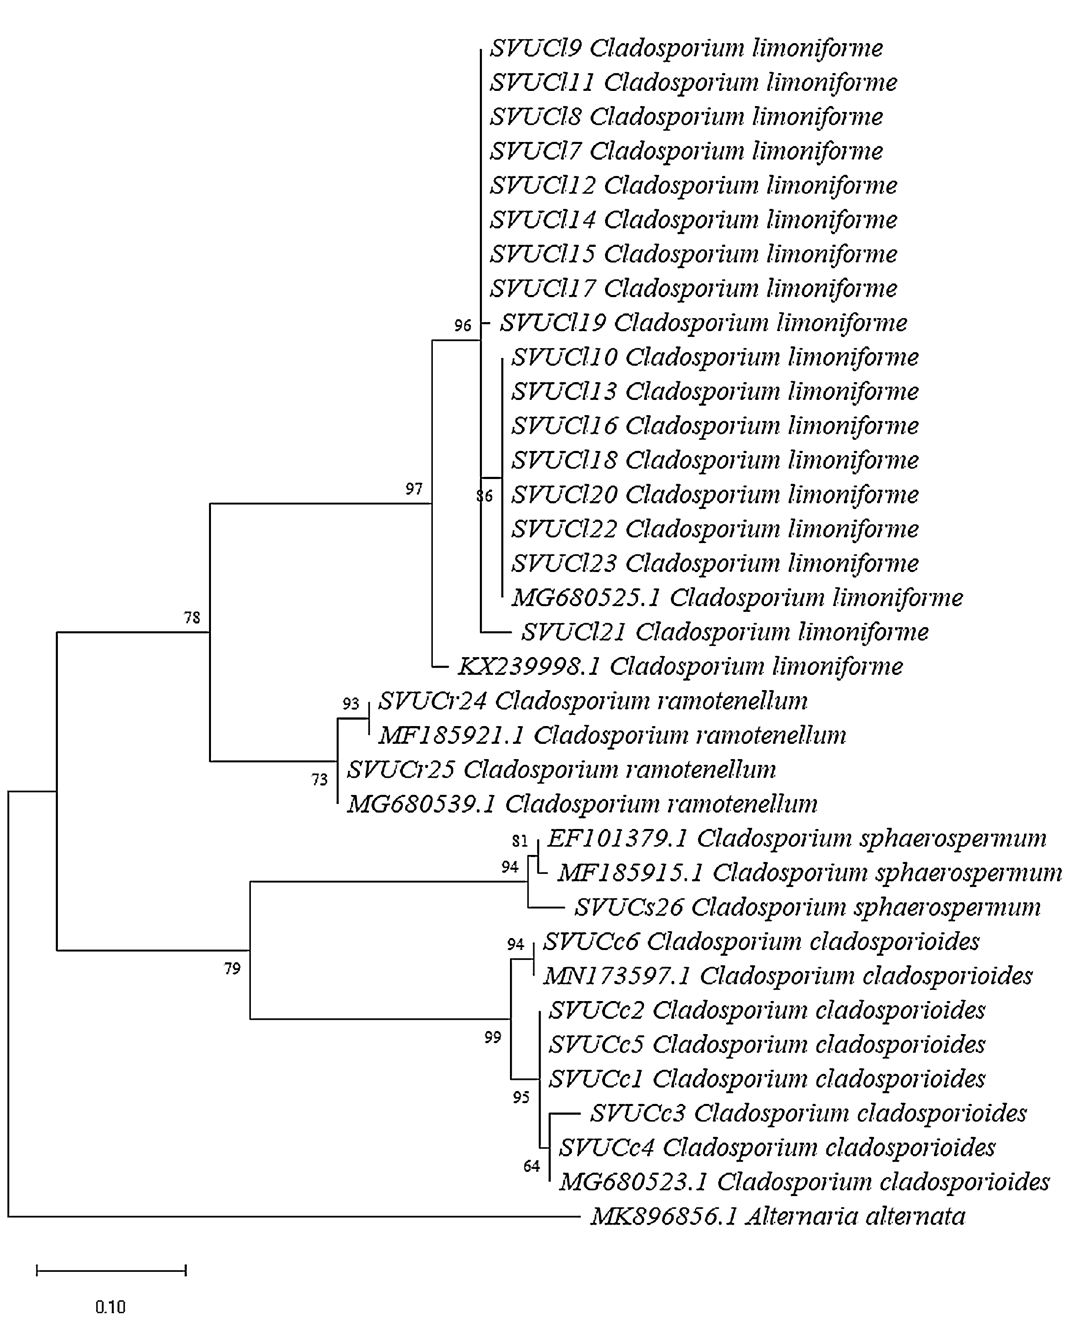
Figure 5. Maximum likelihood phylogenetic tree based on the analysis of ACT gene of the 26 Cladosporium isolates obtained from Vicia faba leaves and pods samples, with strains reference sequences achieved from the